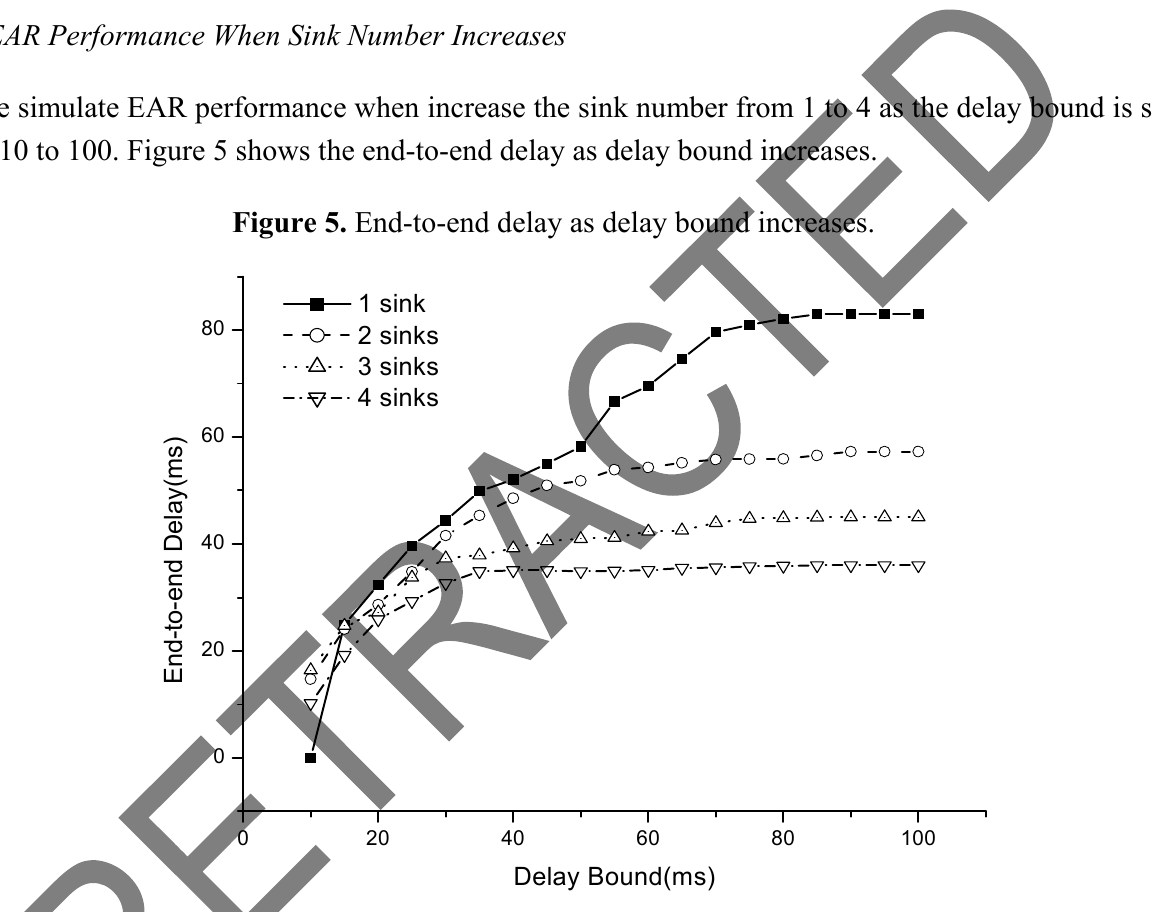
Figure 5. End-to-end delay as delay bound